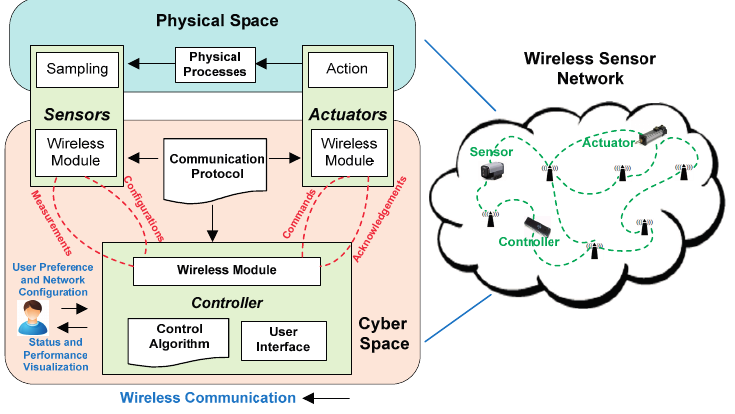
Figure 11. Interacting elements of cyber physical sensor network for infrastructure